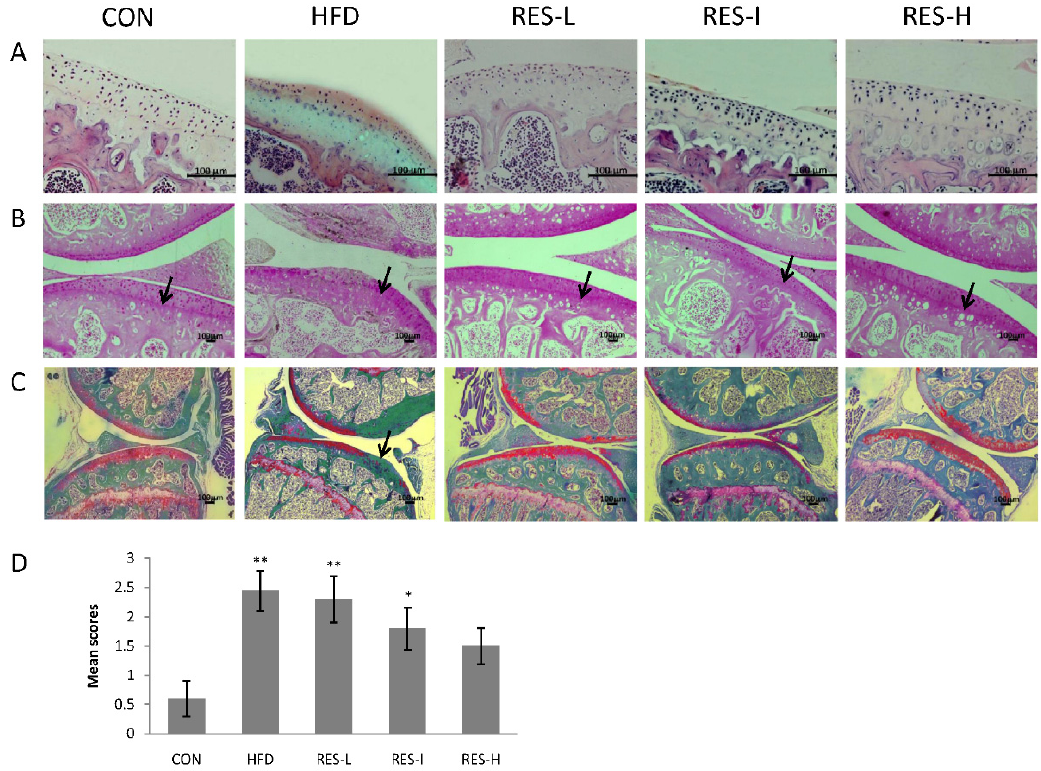
Figure 2. Histological analysis of knee articular cartilage. Representative sections from knee joints that were collected after 12 weeks and stained with: ( A ) H & E (original magnification, 200×); ( B ) Safranin O (original magnification, 100×); and ( C ) Safranin O/Fast Green (original magnification, 40×). Scale bar = 100 m; ( D ) Quantification of modified Mankin scores. Data are expressed as the mean scores ± SE for 10 mice per group. Black arrows indicate the tide lines or articular cartilage lesion areas. ANOVA was used to test for statistical significance. * p < 0.05, ** p < 0.01 versus the CON group.